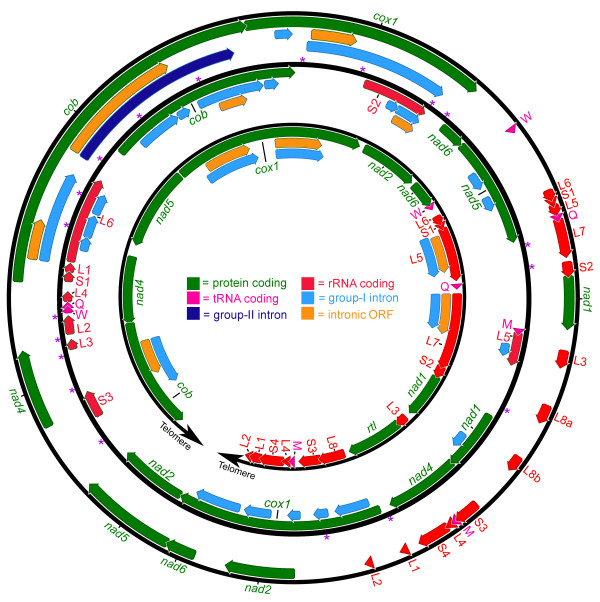
Complete mitochondrial genome maps for Dunaliella salina (middle), Chlamydomonas reinhardtii (inner), and Volvox carteri (outer). The mitochondrial genome of D. salina (this study) is 28.3 kb, that of C. reinhardtii (GenBank accession numbers EU306617-EU306623) ranges from 15.8-18.9 kb, depending on the presence of optional introns, and that of V. carteri (GenBank accession numbers EU760701 and GU084821) is ~35 kb. Note that the C. reinhardtii mtDNA is a linear molecule. Arrows within the coding regions denote transcriptional polarities. The small subunit and large subunit rRNA-coding regions are fragmented into modules. Transfer RNA-coding regions are designated by the single-letter abbreviation of the amino acid they specify. Purple asterisks denote the sites of palindromic repeat clusters (see Figure 5 for more details). Rtl codes for a putative reverse-transcriptase-like protein.